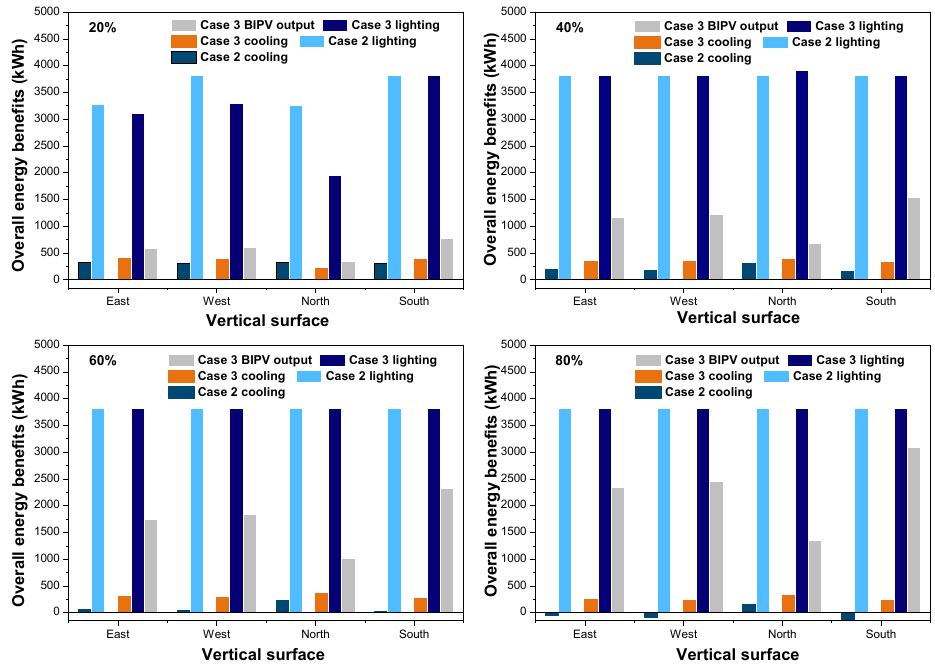
Figure 17. Overall energy benefits for all cases.